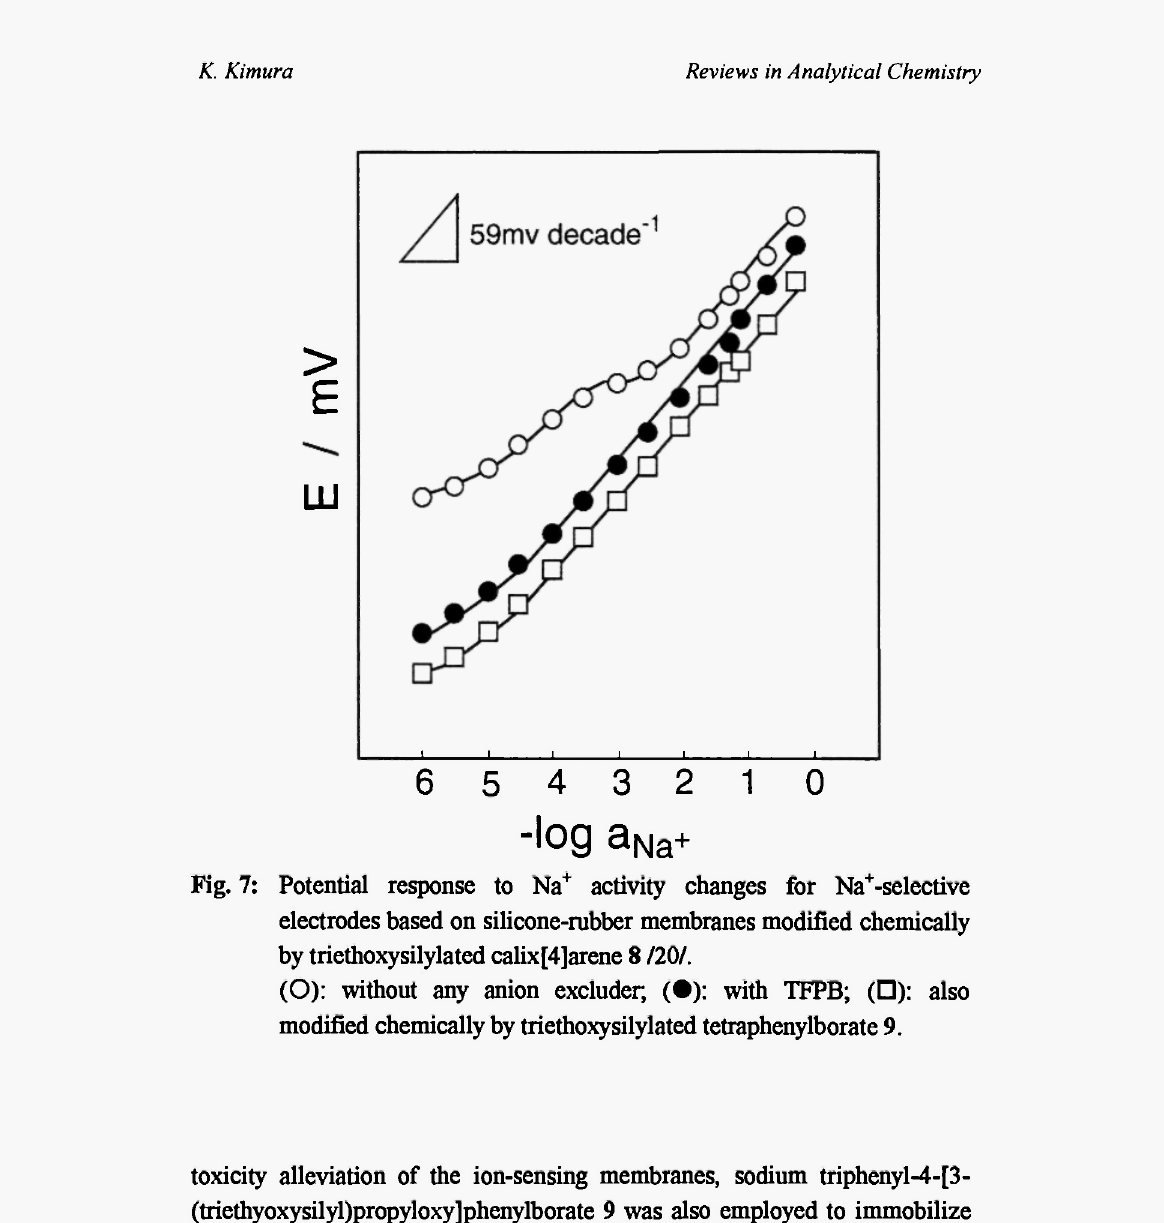
Fig. 7: Potential response to Na + activity changes for Na + -selective electrodes based on silicone-rabber membranes modified chemically by triethoxysilylated calix[4]arene 8